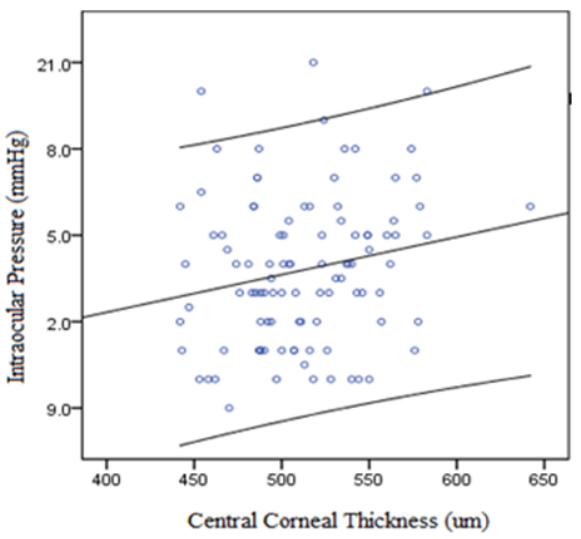
Figure 4: Scatter plot showing the correlation of CCT and IOP of the Black subjects with 95% confidence interval of the re - gression line. ( R 2 = 0.304, r = 0.196, p = 0.05). The regression line represents IOP = 0.013CCT + 7.094.